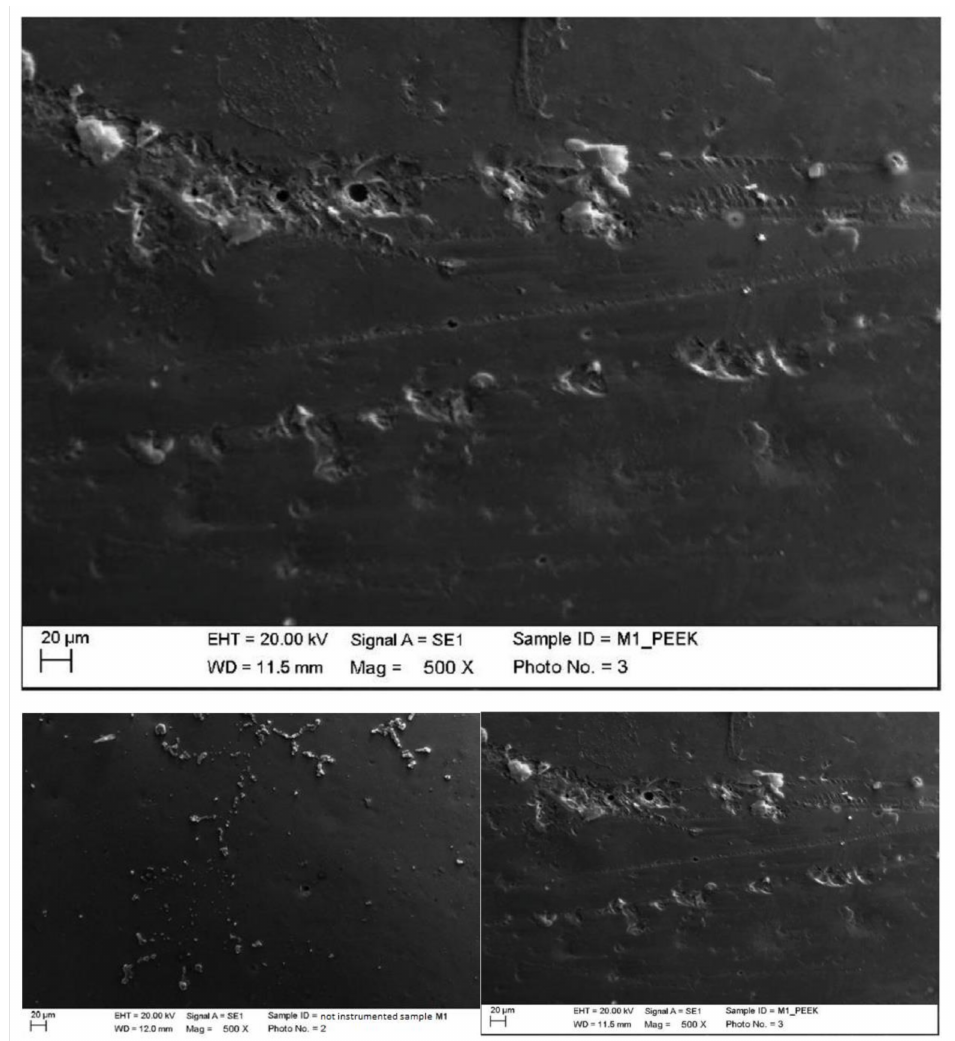
Figure 15. Instrumented ceramic sample M1 with peek insert (500 × ). Comparison before/after